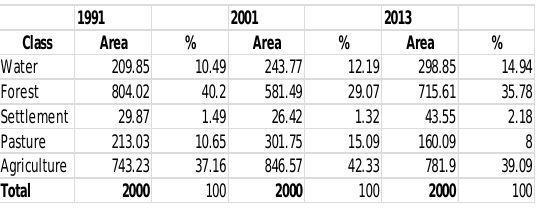
Table 2. Land use/cover area in three decade.